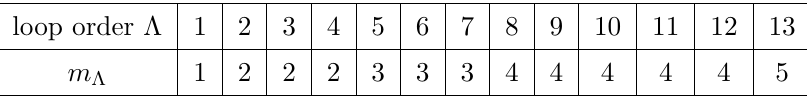
(cid:3) at each loop order